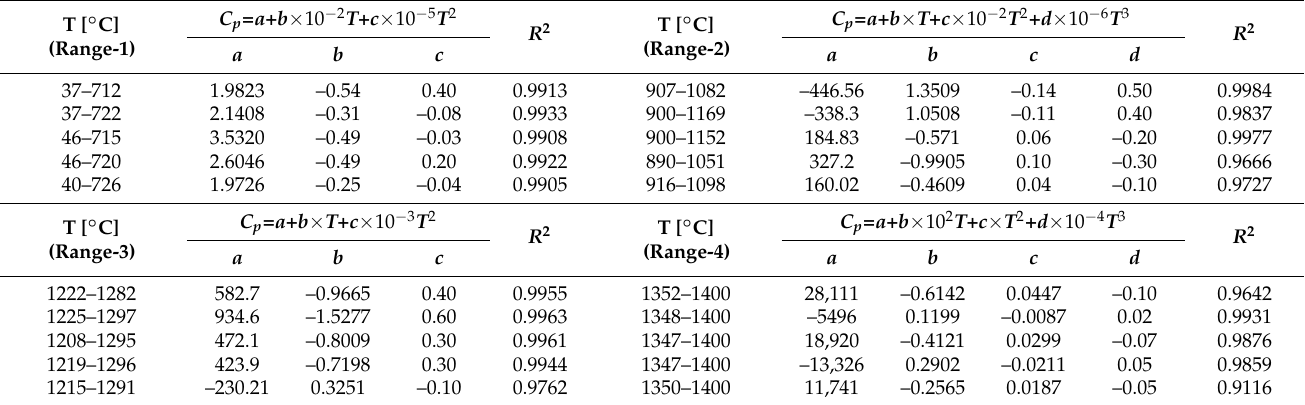
Figure 5. The calculation result of specific heat capacity of BF slag with different contents of MgO. Table 2. The relationship between specific heat capacity and temperature.